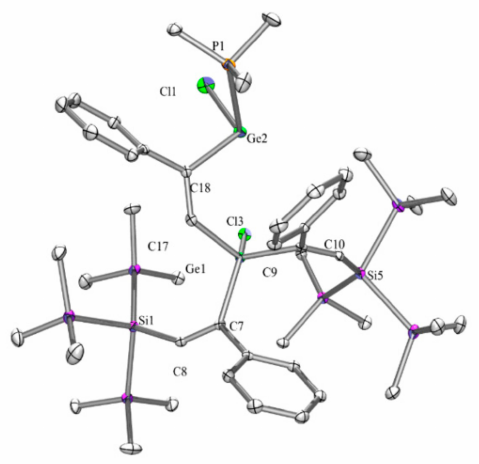
Figure 6. Molecular structure of 11 (thermal ellipsoid plot drawn at the 30% probability level). All hydrogen atoms are omitted for clarity (bond lengths in Å, angles in deg).